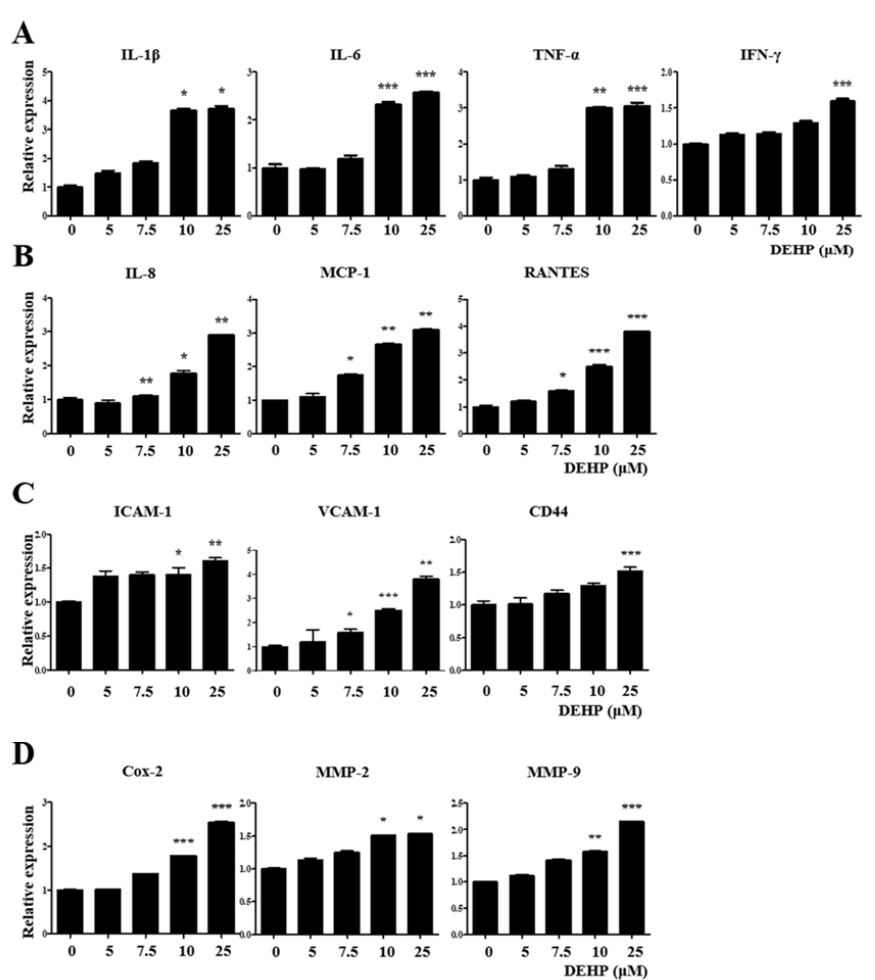
Figure 3. Di-(2-ethylhexyl) phthalate (DEHP) triggers the expression of inflammatory and im- munological mediators in human endometriotic epithelial cells as detected by quantitative reverse transcription-PCR (qRT-PCR). mRNA expression levels of ( A ) proinflammatory cytokines IL-1 β , IL-6 , TNF- α , and IFN- γ ; ( B ) proinflammatory chemokines IL-8 , MCP-1 , and RANTES ; ( C ) cell adhe- sion molecules ICAM-1 , VCAM-1 , and CD44 ; ( D ) COX-2 , MMP-2 , and MMP-9 . Glyceraldehyde-3- phosphate dehydrogenase ( GAPDH ) was used as the housekeeping gene. All data are expressed as relative values against their respective control group. Data represent the means ± standard deviation of three independent experiments. * p < 0.05, ** p < 0.01, and *** p < 0.001 (vs. control). Human IL-8 (C–X–C motif chemokine ligand 8, CXCL-8), monocyte chemoattractant protein-1 (MCP-1; C–C motif chemokine ligand 2, CCL2), and regulated upon fold ( p < 0.001), and 3.1 ‐ fold ( p < 0.01), respectively, than those in the control (Figure 3B).